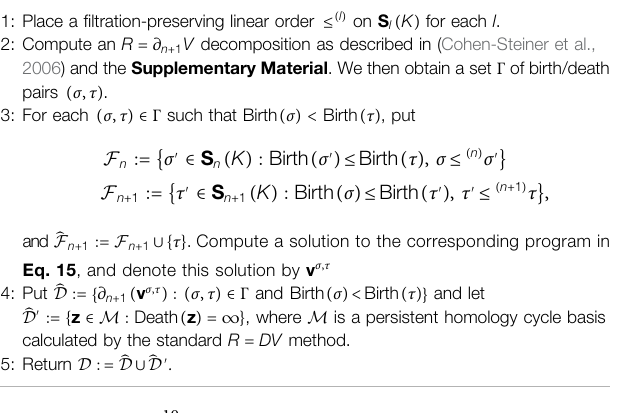
Algorithm 2 | Triangle-loss persistent cycle